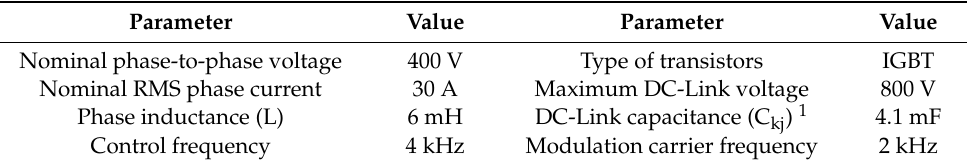
Table 1. Converter characteristics.